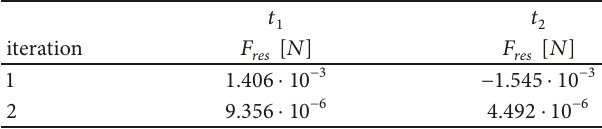
Table 4: Residual force in subsequent equilibrium iterations at two selected time increments 𝑡 1 and 𝑡 2